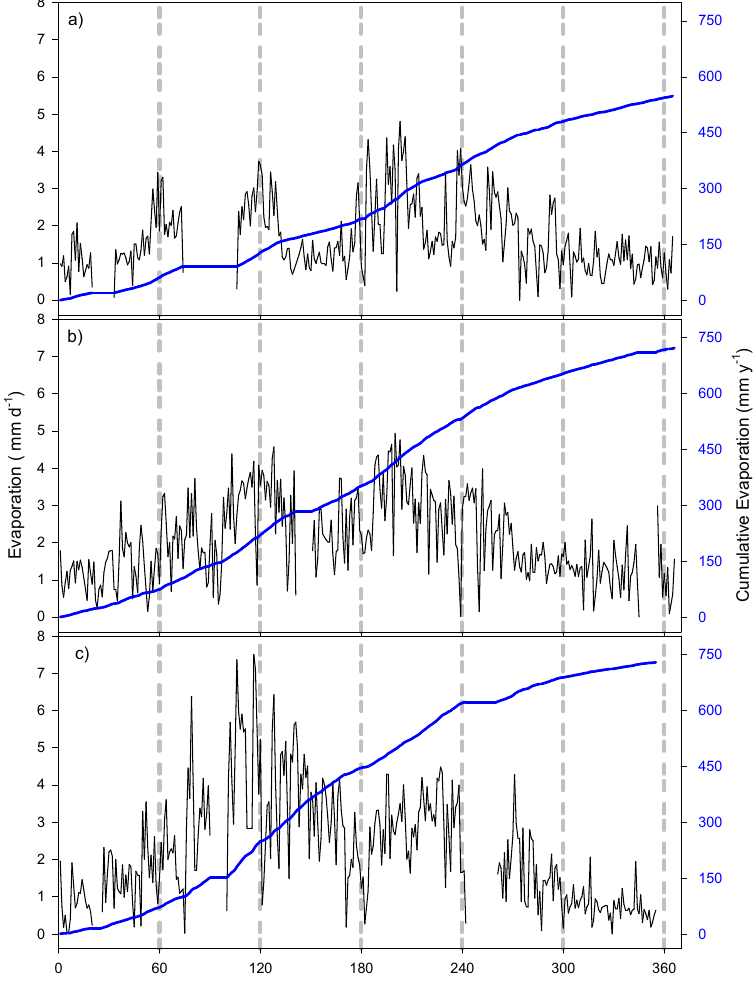
Figure 5. Daily mean values of evaporative flux for ( a ) 2007, ( b ) 2008, and ( c ) 2009. The blue diagonal line is the year cumulative annual of ET 493, 743, and 746 mm during 2007, 2008, and 2009, respec- tively.